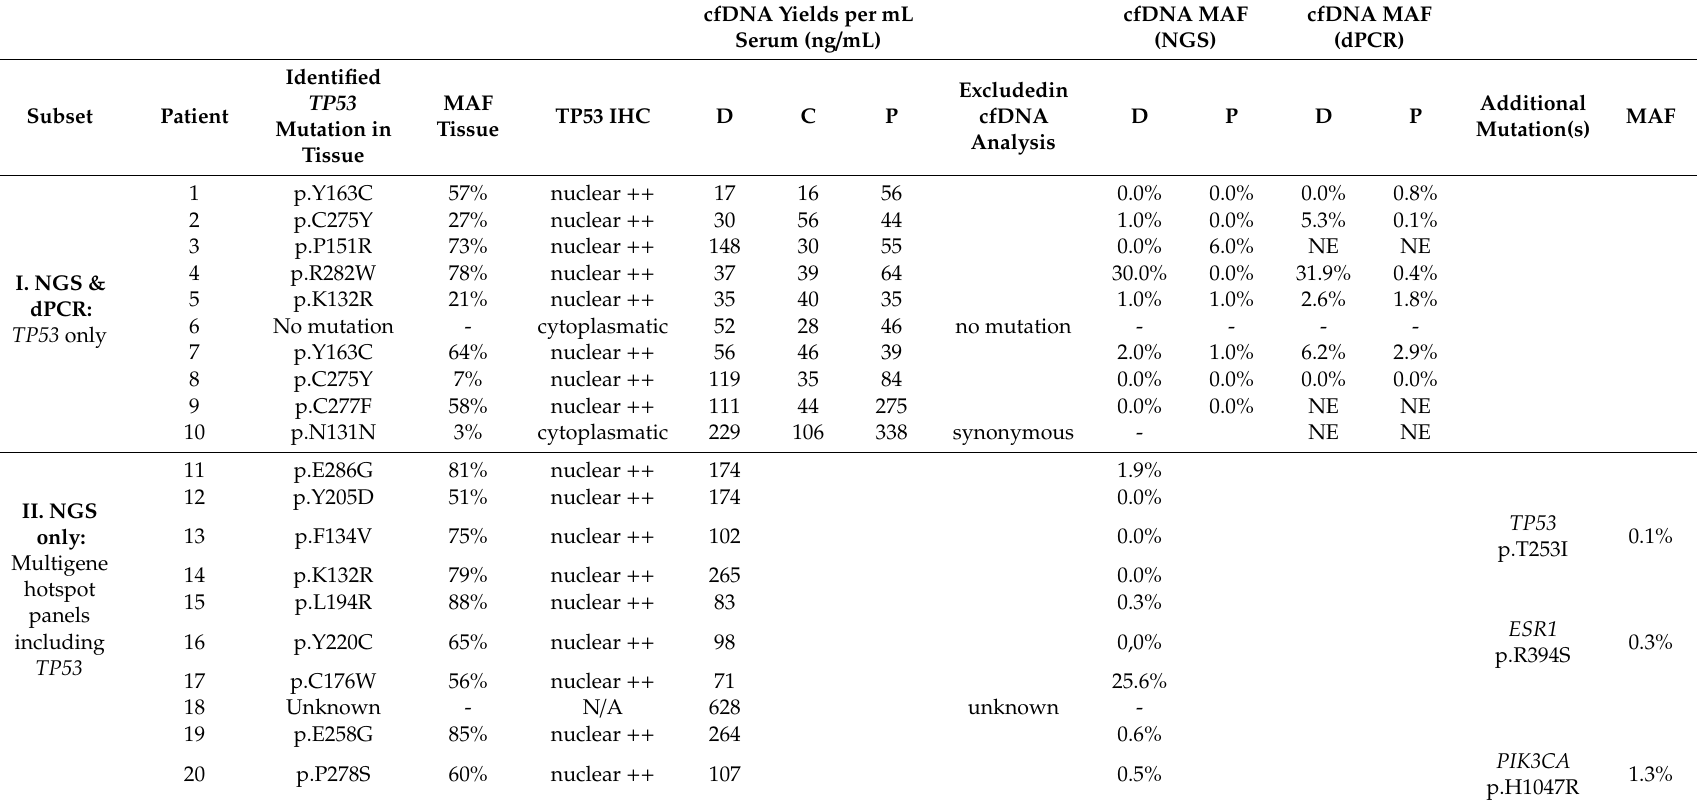
Table 3. Tumor tissue and serum